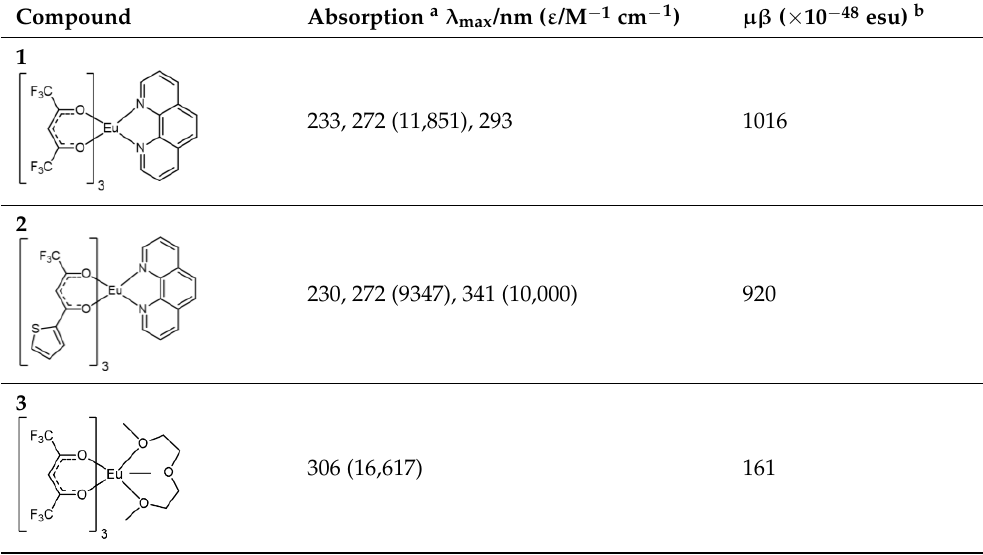
Table 1. Main absorption bands in the UV-visible spectra and second-order NLO response. Compound